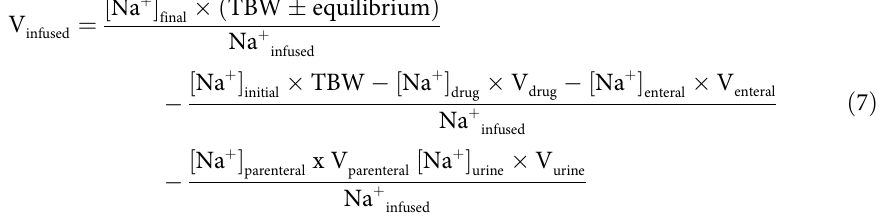
S1 Table. Patient characteristics. S2 Table. Total inputs and outputs in the study